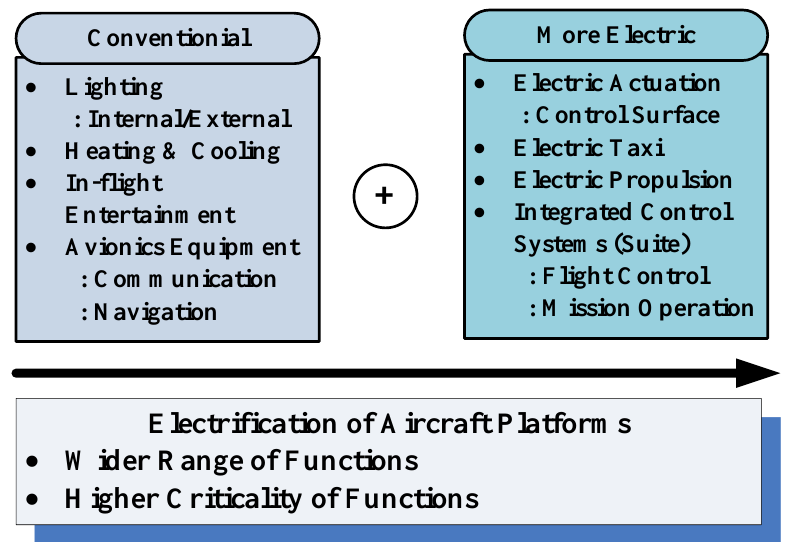
Figure 1. Increased use of electrical power in a more electric aircraft (MEA).